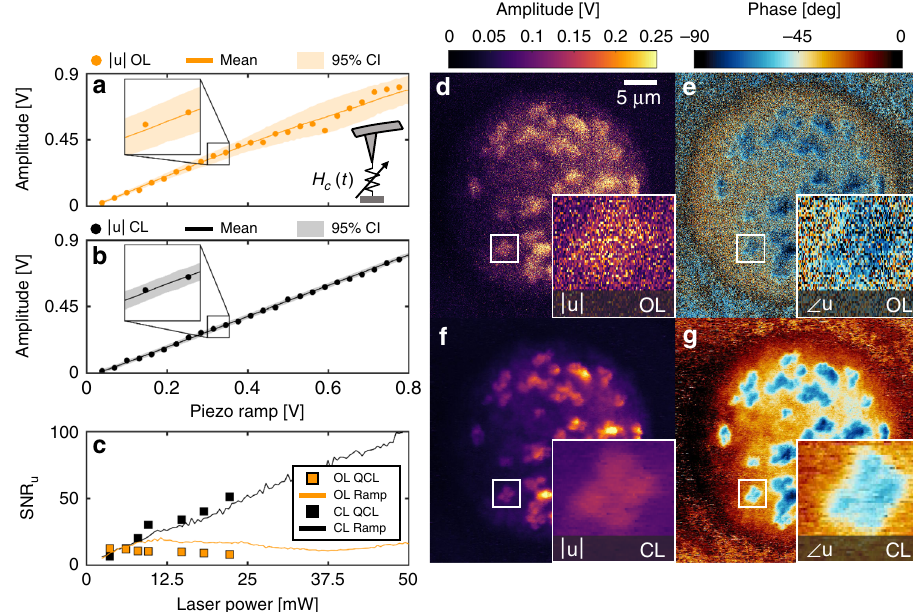
Fig. 3 Effects of time-varying cantilever resonance in AFM-IR. a Amplitude of the cantilever de fl ection voltage demodulated at fi xed 1007 kHz (6th resonance mode) resulting from driving the piezo amplitude from 0 to 1 V within 0.5 s (single scan). The recorded de fl ection signal was scaled by an averaged measurement of responsivity to match the closed-loop signal | u | while retaining the noise behavior of the raw de fl ection signal. Data points represent samples taken from a single representative scan plotted with mean and 95% con fi dence intervals (CI) of 50 repeat scans. Signal variance (noise) was observed to be constant for low signal (below. 1V) and then increases linearly with the cantilever de fl ection. b Amplitude of the closed loop (CL) responsivity corrected signal under the same conditions as ( a ). The CL signal exhibits constant noise equal the minimum noise achieve in the OL signal (i.e. at 0V from (a)). ( c ) Signal to noise ratio (SNR) for the OL and CL ramped signals from ( a ) and ( b ) respectively. SNR was also measured using the signal produced by a 400 nm SU8 fi lm heated by a Quantum Cascade Laser (QCL) at discrete laser power levels for both OL and CL modes. The laser power was correlated to the ramp voltage (x-axis) using the relation between the CL signal and laser power. The SNR of the QCL driven signal exhibits the same behavior as the piezo ramp measurements suggesting the OL noise scales with cantilever de fl ection (not laser power) most likely due to time-dependent variations in the cantilever ’ s resonance behavior. d , e OL amplitude and phase responsivity corrected AFM-IR images of chromosomes from a metastatic breast cancer cell line (MCF10A series) collected at fi xed 360 kHz (3rd resonance). f , g Same sample and conditions as ( d ) and ( e ) except operated in CL. Both OL and CL were collected with resonance-enhanced sensitivity; however, the OL signal is degraded by rapid time-variations in resonance resulting in high noise and inaccurate phase signal due to processing the ratio of noisy